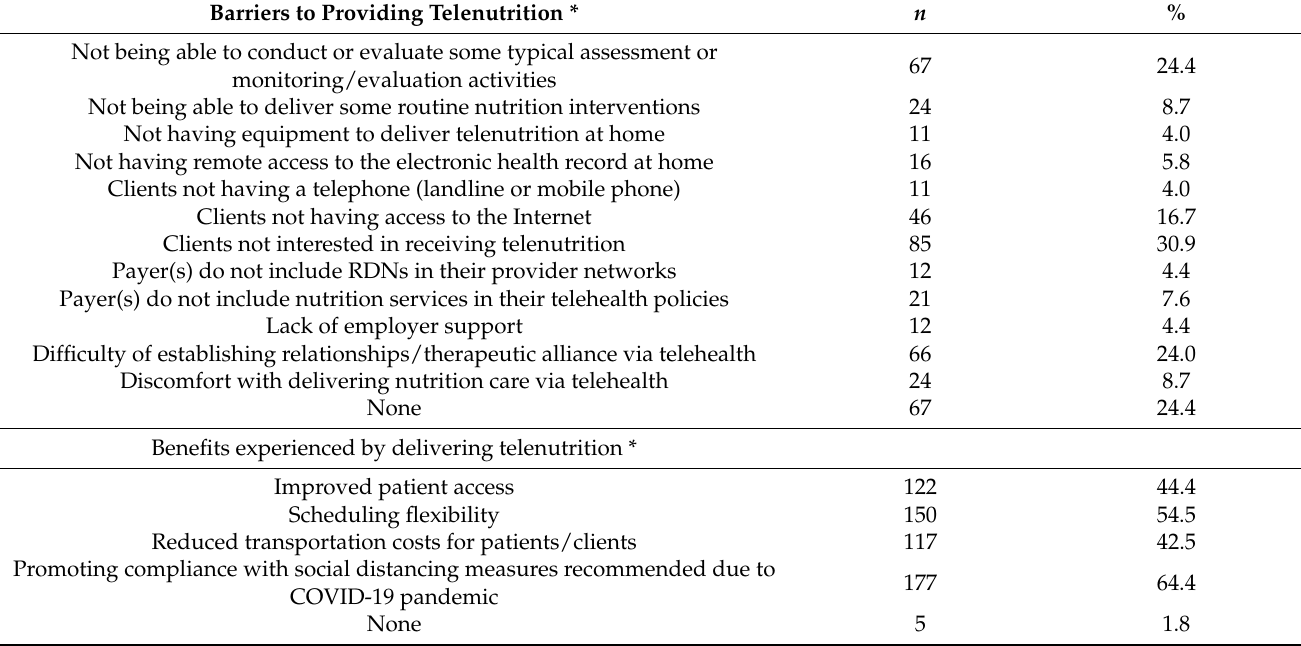
therapeutic alliances via telemedicine with their patients/clients. The benefits reported by RDNs were ensuring compliance with social-distancing guidelines for the COVID- scheduling flexibility (54.5%) (Table 3). Barriers and benefits encountered by RDNs providing telenutrition during the COVID-19 pandemic.